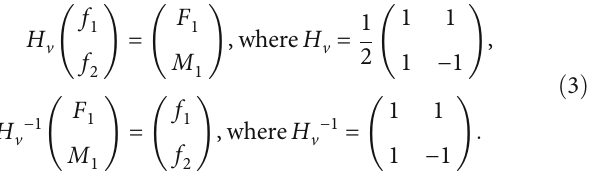
ff erent v -transform for di